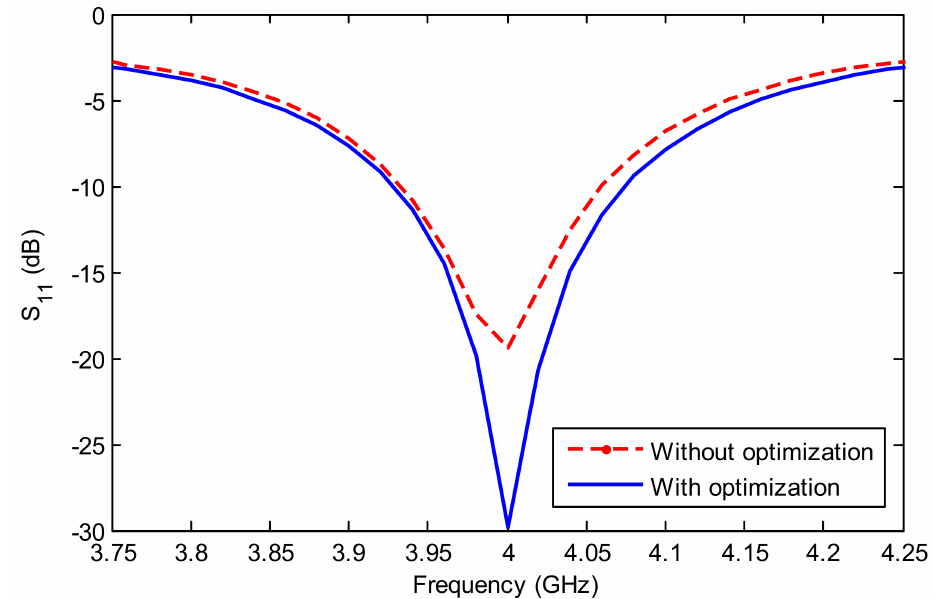
Figure 11. Comparison between the microstrip patch antenna with thin-film material before and after